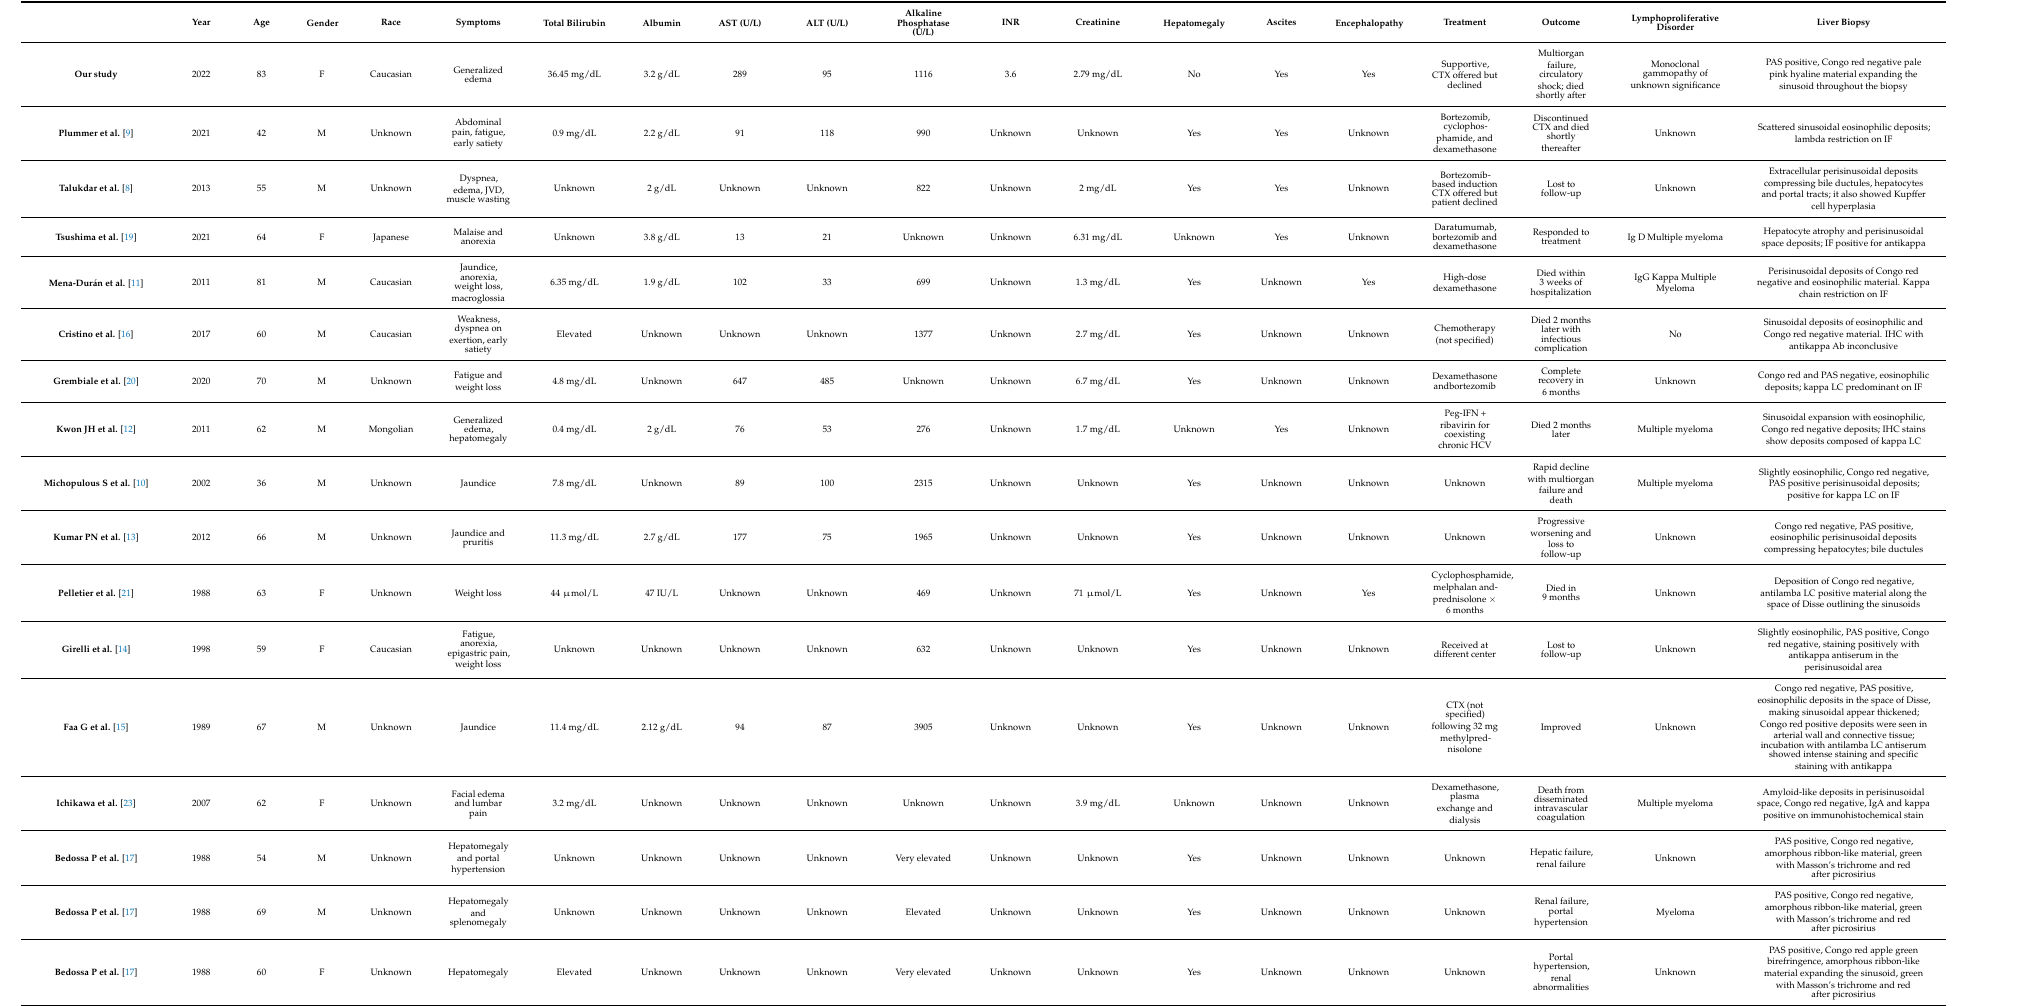
Table 1. Characteristics of reported cases of LCDD with hepatic